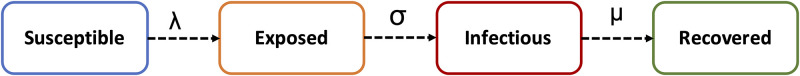
An Illustration of the underlying states of the Susceptible-Exposed-Infectious-Recovered Model(SEIR).